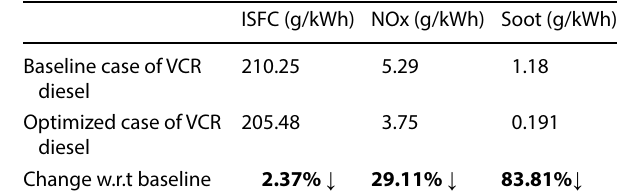
Table 7 Comparison of baseline and optimized cases of VCR diesel